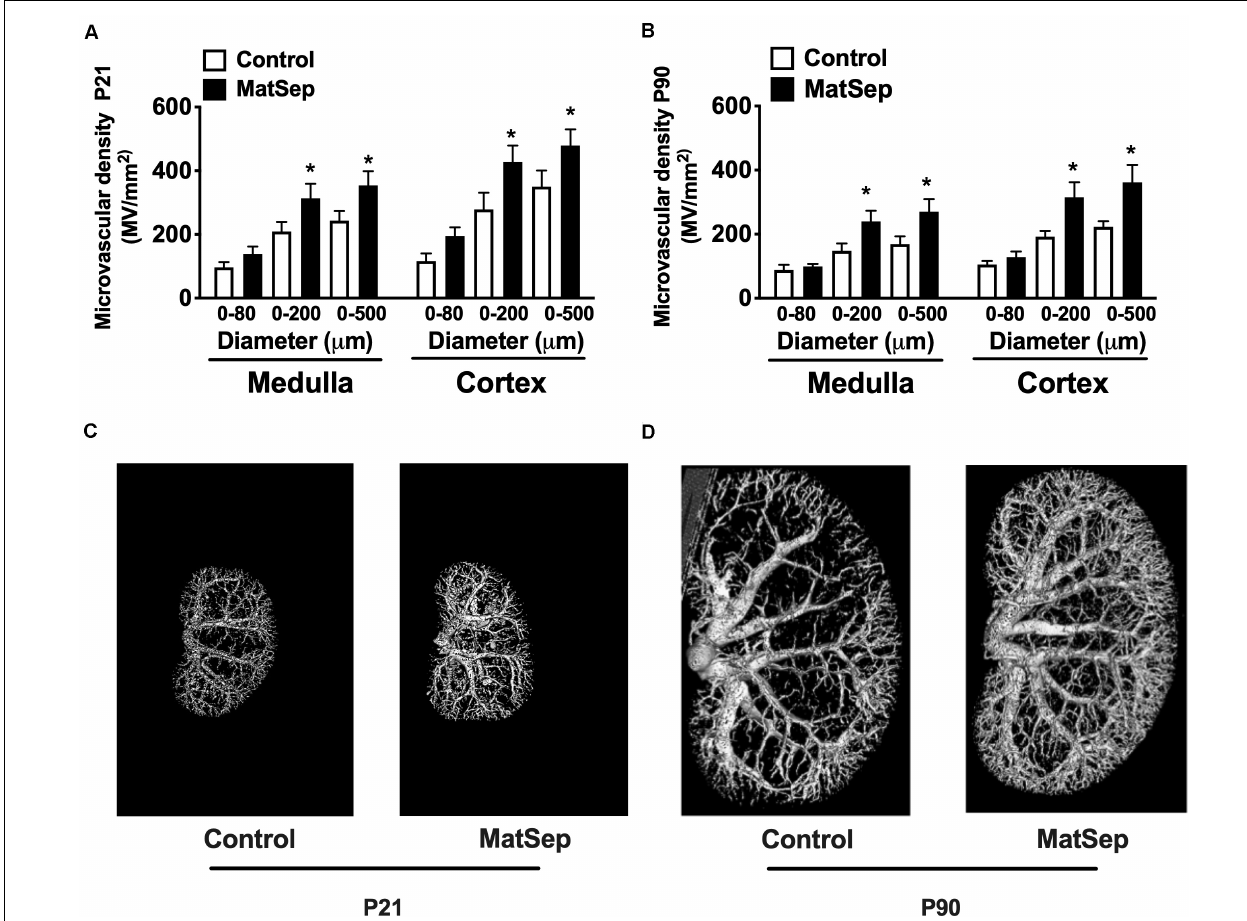
FIGURE 2 | Effect of maternal separation (MatSep) on microvascular density in renal cortex and medulla at (A) P21 and (B) P90. Renal microphotographs in Control (right) and MatSep (left) at (C) P21 and (D) P90. P: postnatal day. * p < 0.05 vs. C. n = 5–7 per